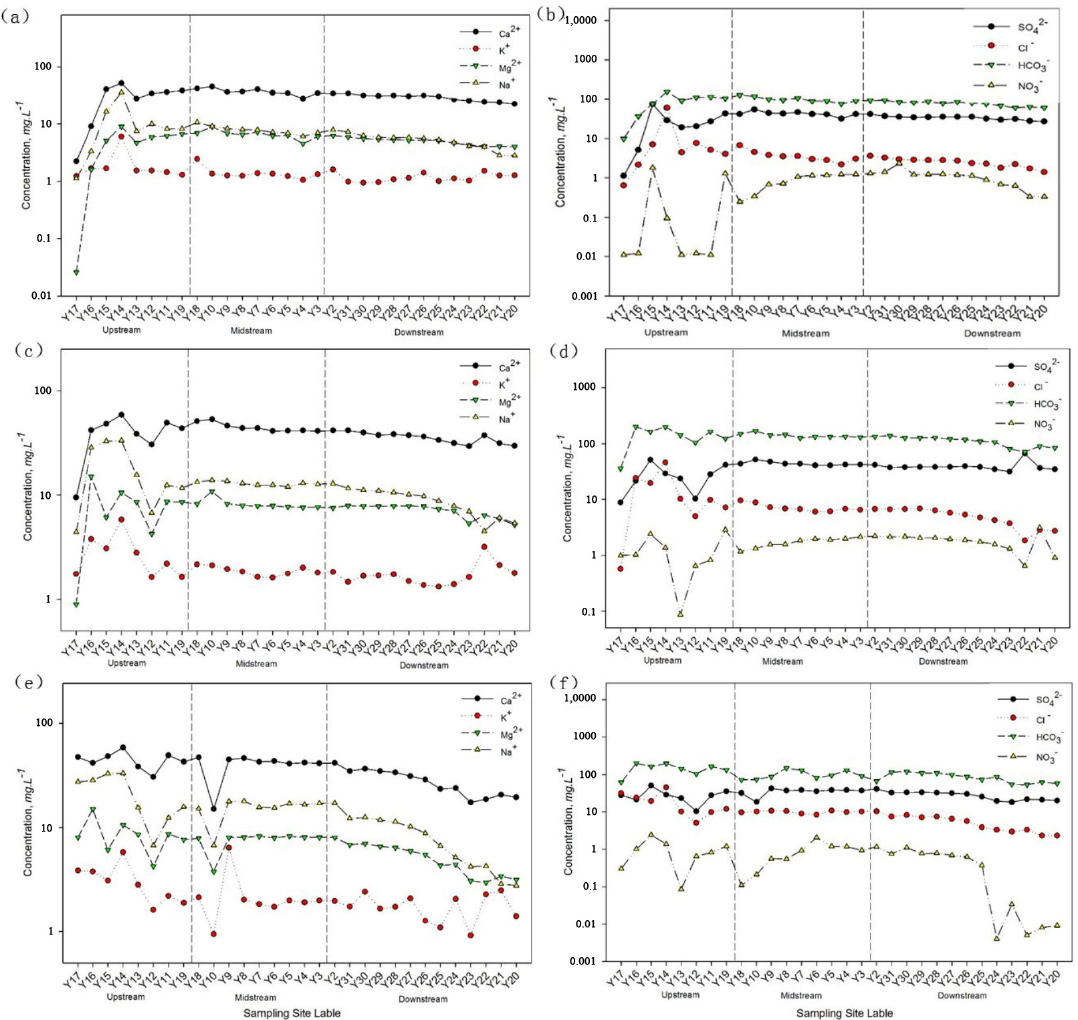
Figure 5. The variation of major ion concentrations along 800 km of the Yarlung Tsangpo River main channel during wet, normal and dry periods. ( a ) Cation concentration changes in wet season, ( b ) anion concentration changes in wet season, ( c ) cation concentration changes in normal season, ( d ) anion concentration changes in normal season, ( d ) anion concentration changes in normal season, ( e ) cation concentration changes in dry season, ( f ) anion concentration changes in dry season. Y17-Y20 represents the sampling point location in the main stream of the Yarlung Tsangpo River.